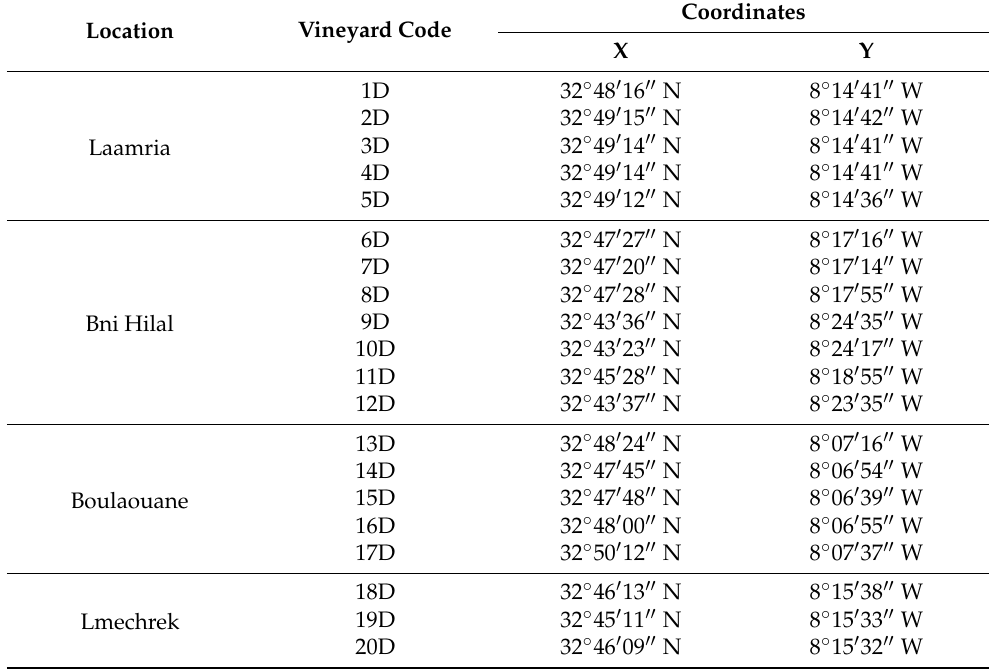
Table 2. Coordinates of the sampling